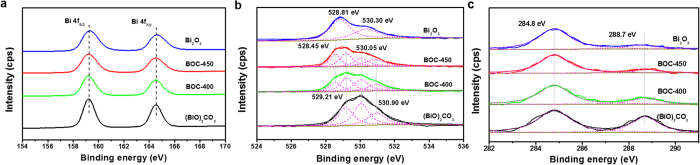
High-resolution XPS spectra of (BiO)2CO3, BOC-400, BOC-450, and α-Bi2O3 samples.(a) Bi 4f, (b) O 1s, and (c) C 1s.